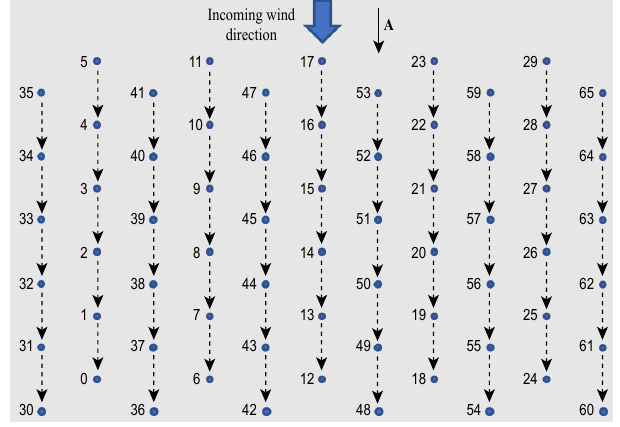
Figure 4. A regular hexagonal layout with hexagonal side of 4 D , showing direction of inflow. Consider a major wake zone m of T turbines with power productions { P i } i ∈T and control settings { a i } i ∈T that are standing in the wake of each other, with a free-stream inflow U ∞ from the direction illustrated on Figure 3. The optimization variable considered in this study for plant power maximization is the axial induction factor a ; hence, an adjust- ment in a of any i ∈ T in m affects turbine i ’s power production and those of others in its downstream. Optimal settings of a ∀ i ∈ T , ∀ m ∈ M , and ∀ b ∈ B , thus, will produce a maximized plant power output per instance of